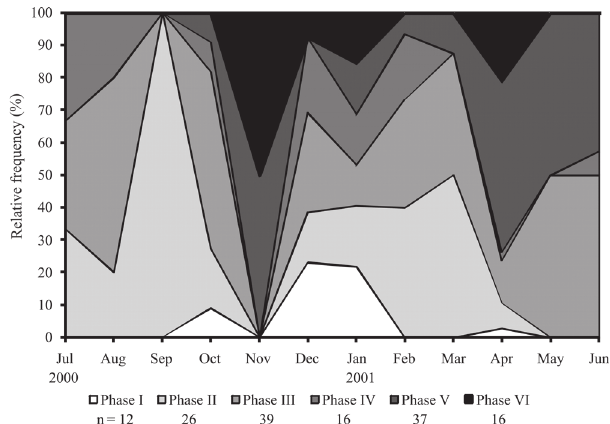
Fig. 5. Reproductive cycle of the Sinaloa cichlid Cichlasoma beani in the Aguamilpa Reservoir in Nayarit,